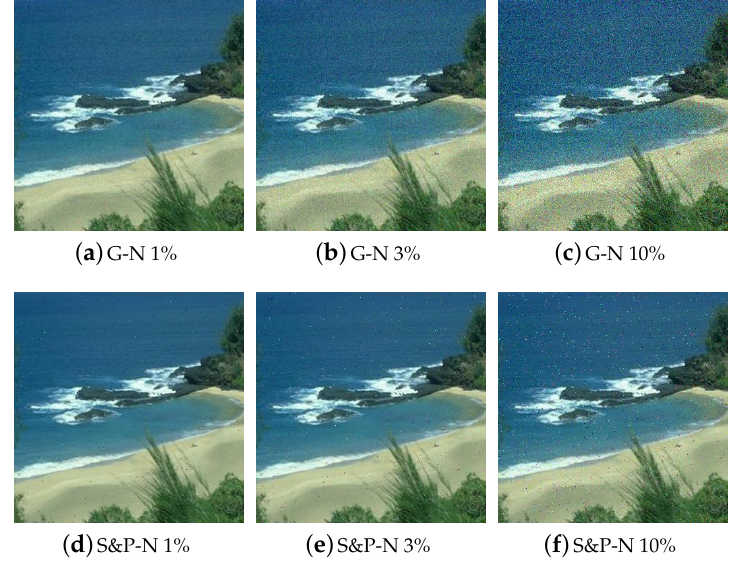
Figure 14. Example of images with Gaussian, salt, and pepper noise of 1%, 3%, and 10%,